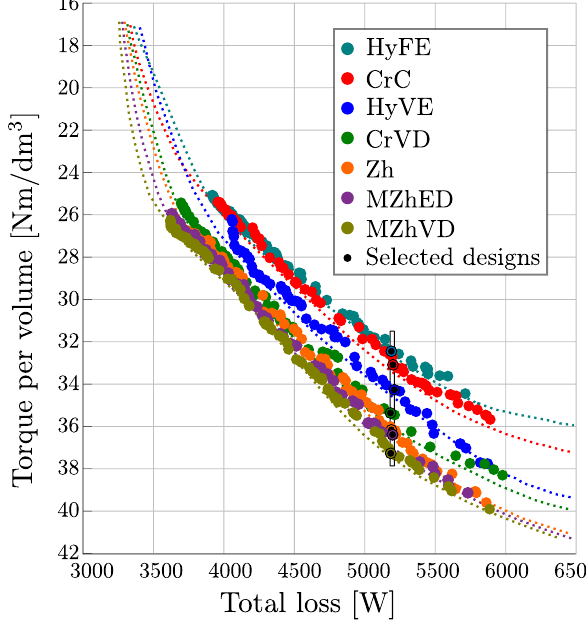
Figure 13. Validated Pareto fronts for each design variant [21].